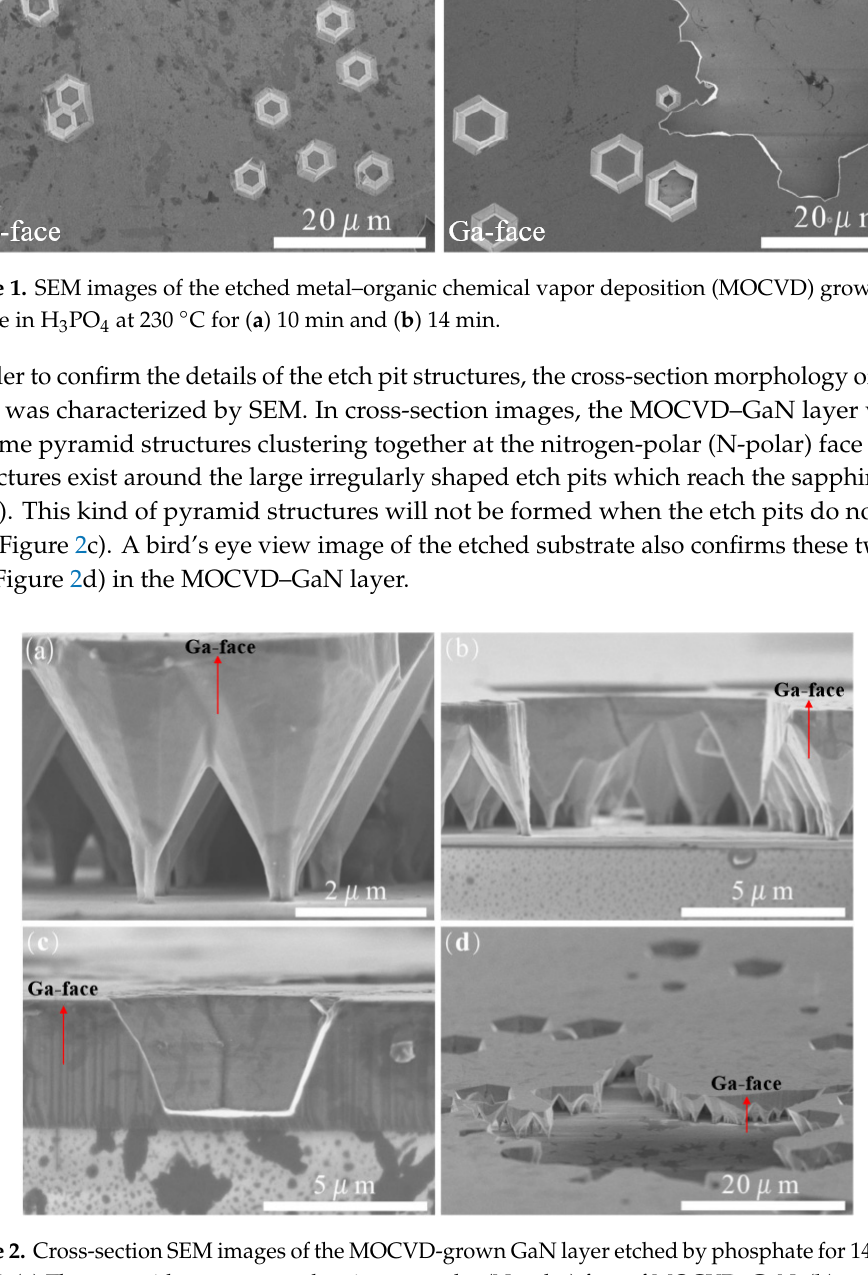
Figure 1. SEM images of the etched metal–organic chemical vapor deposition (MOCVD) grown GaN surface in H 3 PO 4 at 230°C for ( a ) 10 min and ( b ) 14 min.